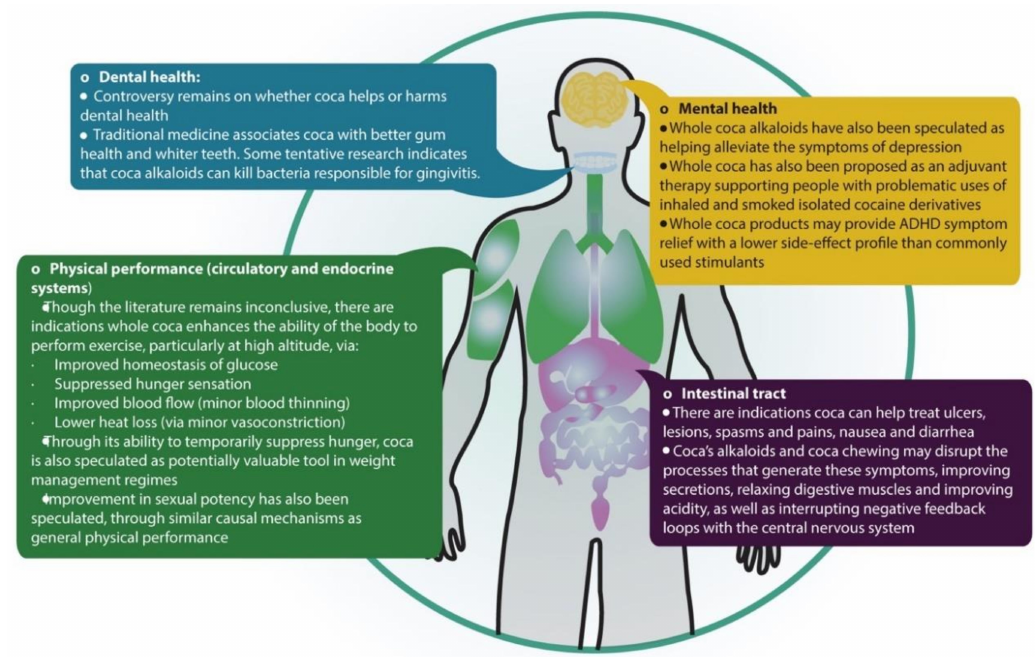
Figure 7. Potential biomedical uses of the coca plant across mental health, dental health, physical performance, and intestinal